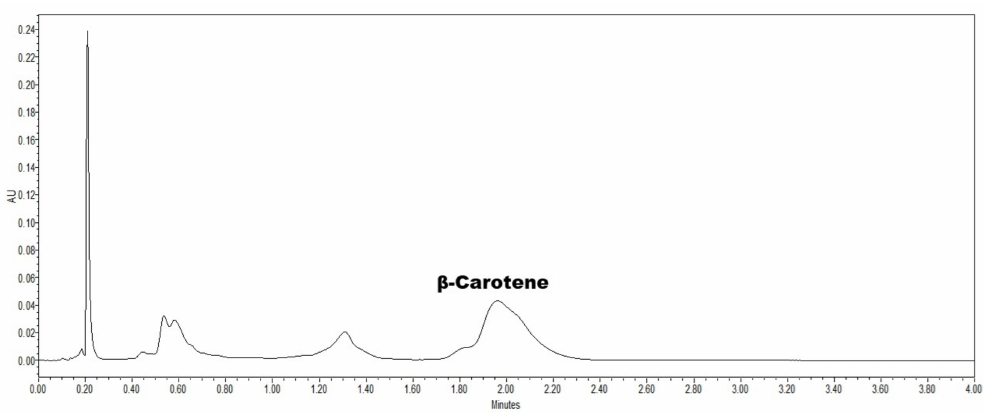
Figure A3. Chromatogram of leaves extracts obtained from habanero pepper plants grown in black